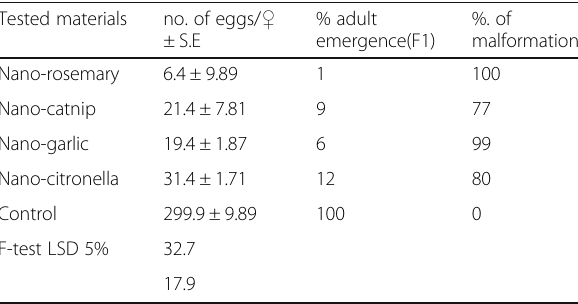
Table 5 Effect of nano on number of laid eggs/female and % of adult emergence (F1) of C. maculatus during storage periods Tested